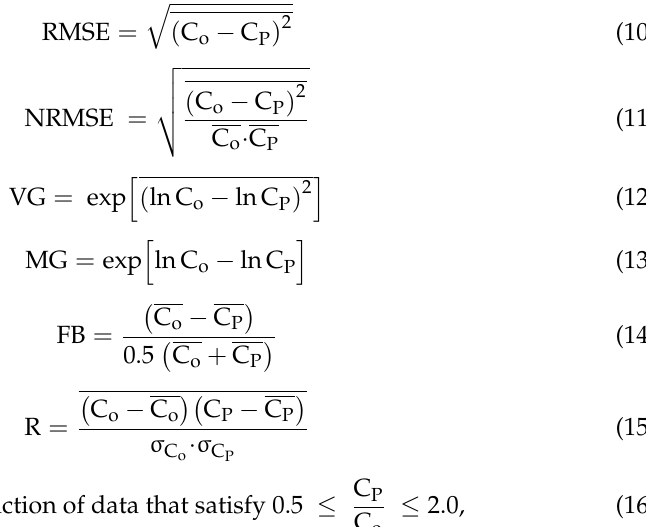
Figure 2. Daily variation of the PM 2.5 emission rate on the road in the target area. For statistical validation, we used the root mean square error (RMSE), normalized root mean square error (NRMSE), geometric mean variance (VG), geometric mean bias (MG), fractional bias (FB), correlation coefficient (R), and fraction within a factor of two